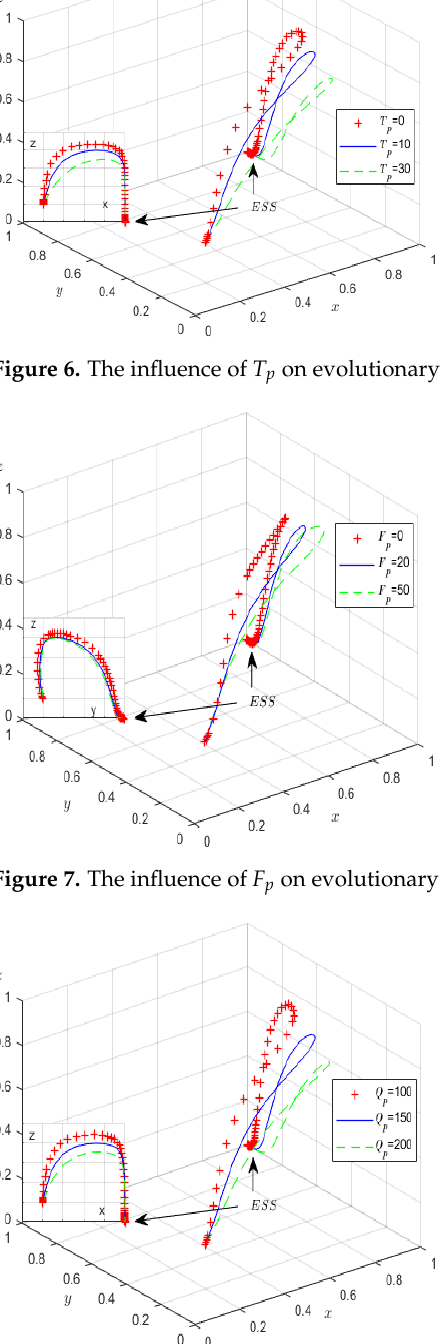
Q is assigned p